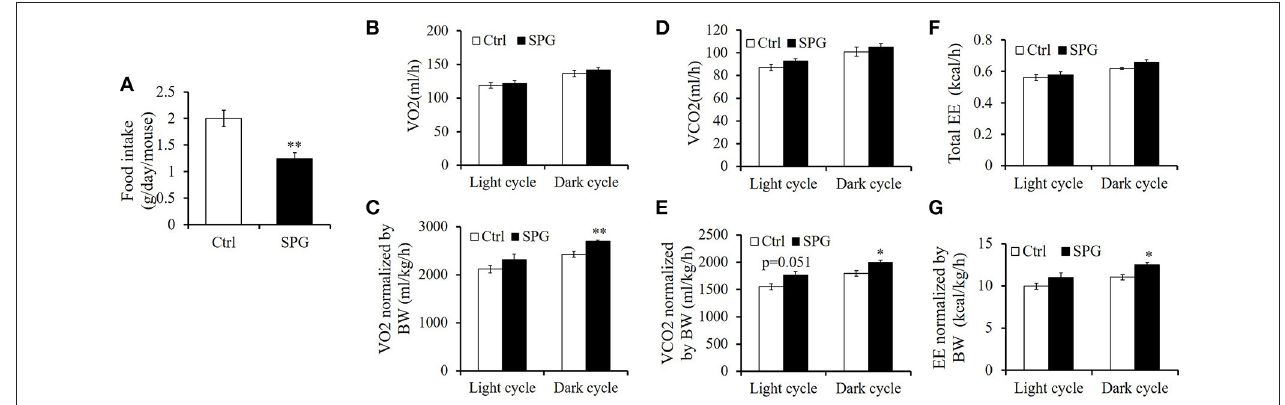
FIGURE 6 | Effect of supaglutide on food intake and energy expenditure in the DIO mice. (A) Food intake. Oxygen consumption (VO2) expressed as per mouse in (B) and normalized by body weight (BW) in (C) . Carbon dioxide release (VCO2) expressed as per mouse in (D) and normalized by BW in (E) . Energy expenditure (EE) expressed as per mouse in (F) and normalized by BW in (G) . Significant difference between control and SPG is determined using unpaired Student’s t -test. All values are means ± SE ( n = 4 for each group). * p < 0.05; ** p < 0.01.